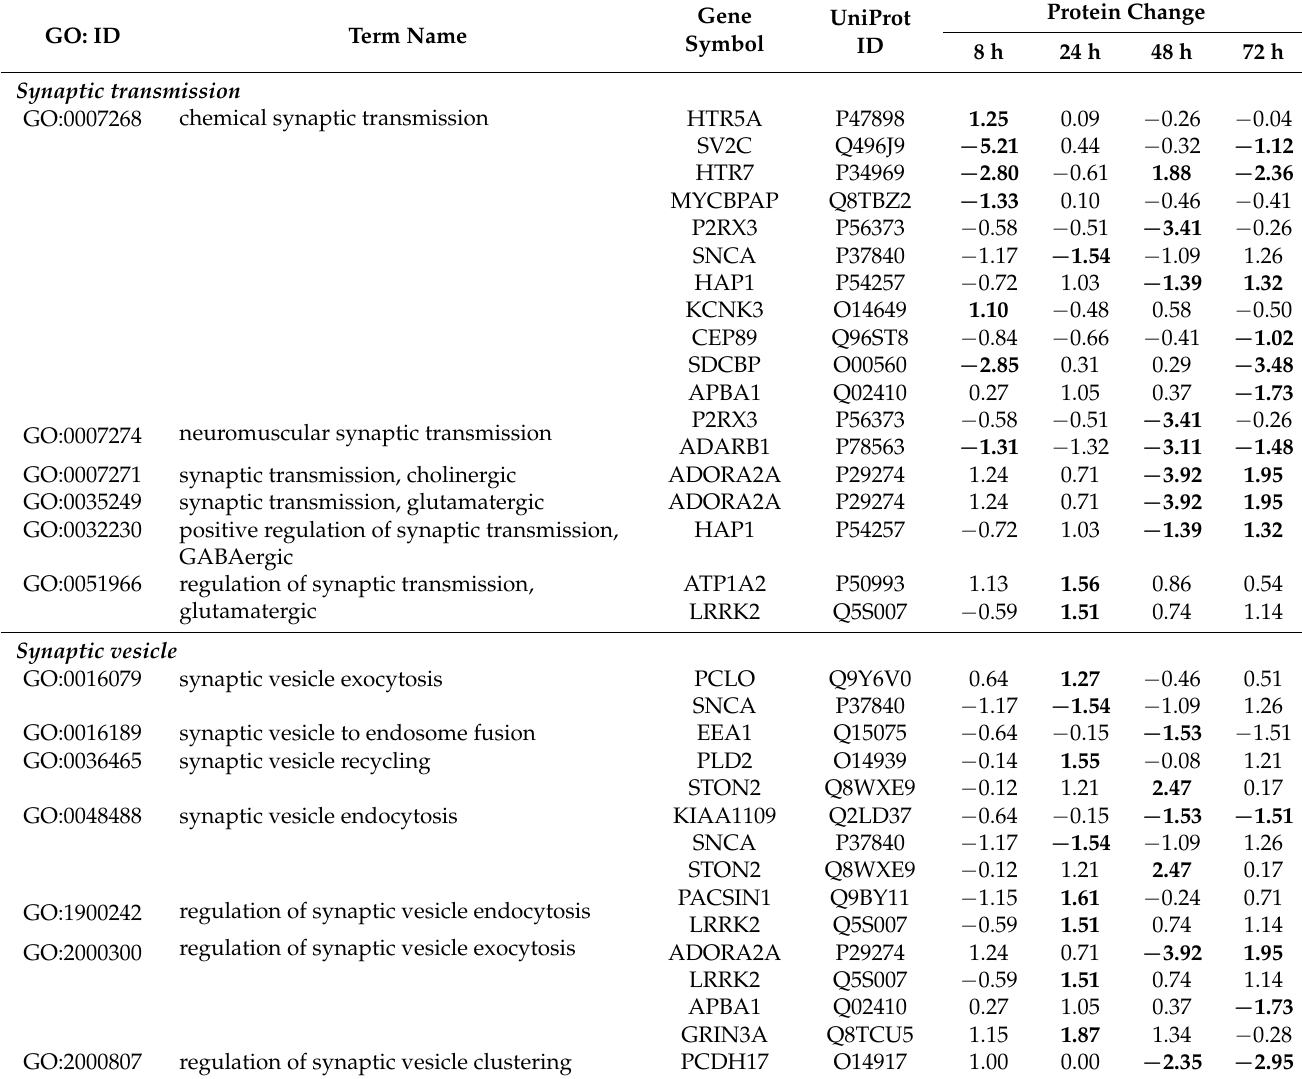
Table 2. Gene ontology of DEPs associated with neuronal